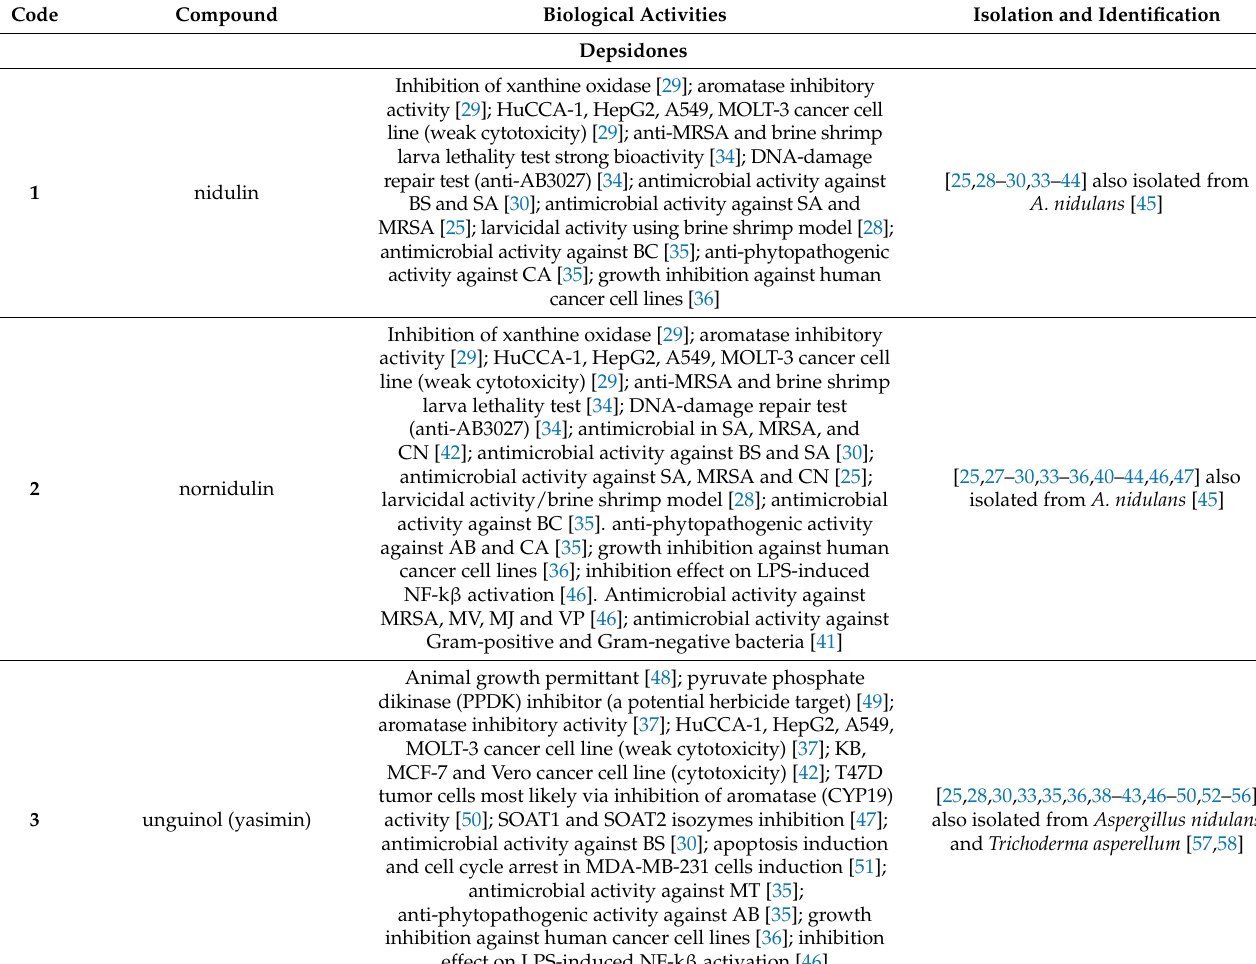
Table 1. All the compounds identified in A. unguis were organized by code, showing for each one (I) the references that report the isolation and identification; (II) the chemical class to which they belong and (III) the biological activities of each